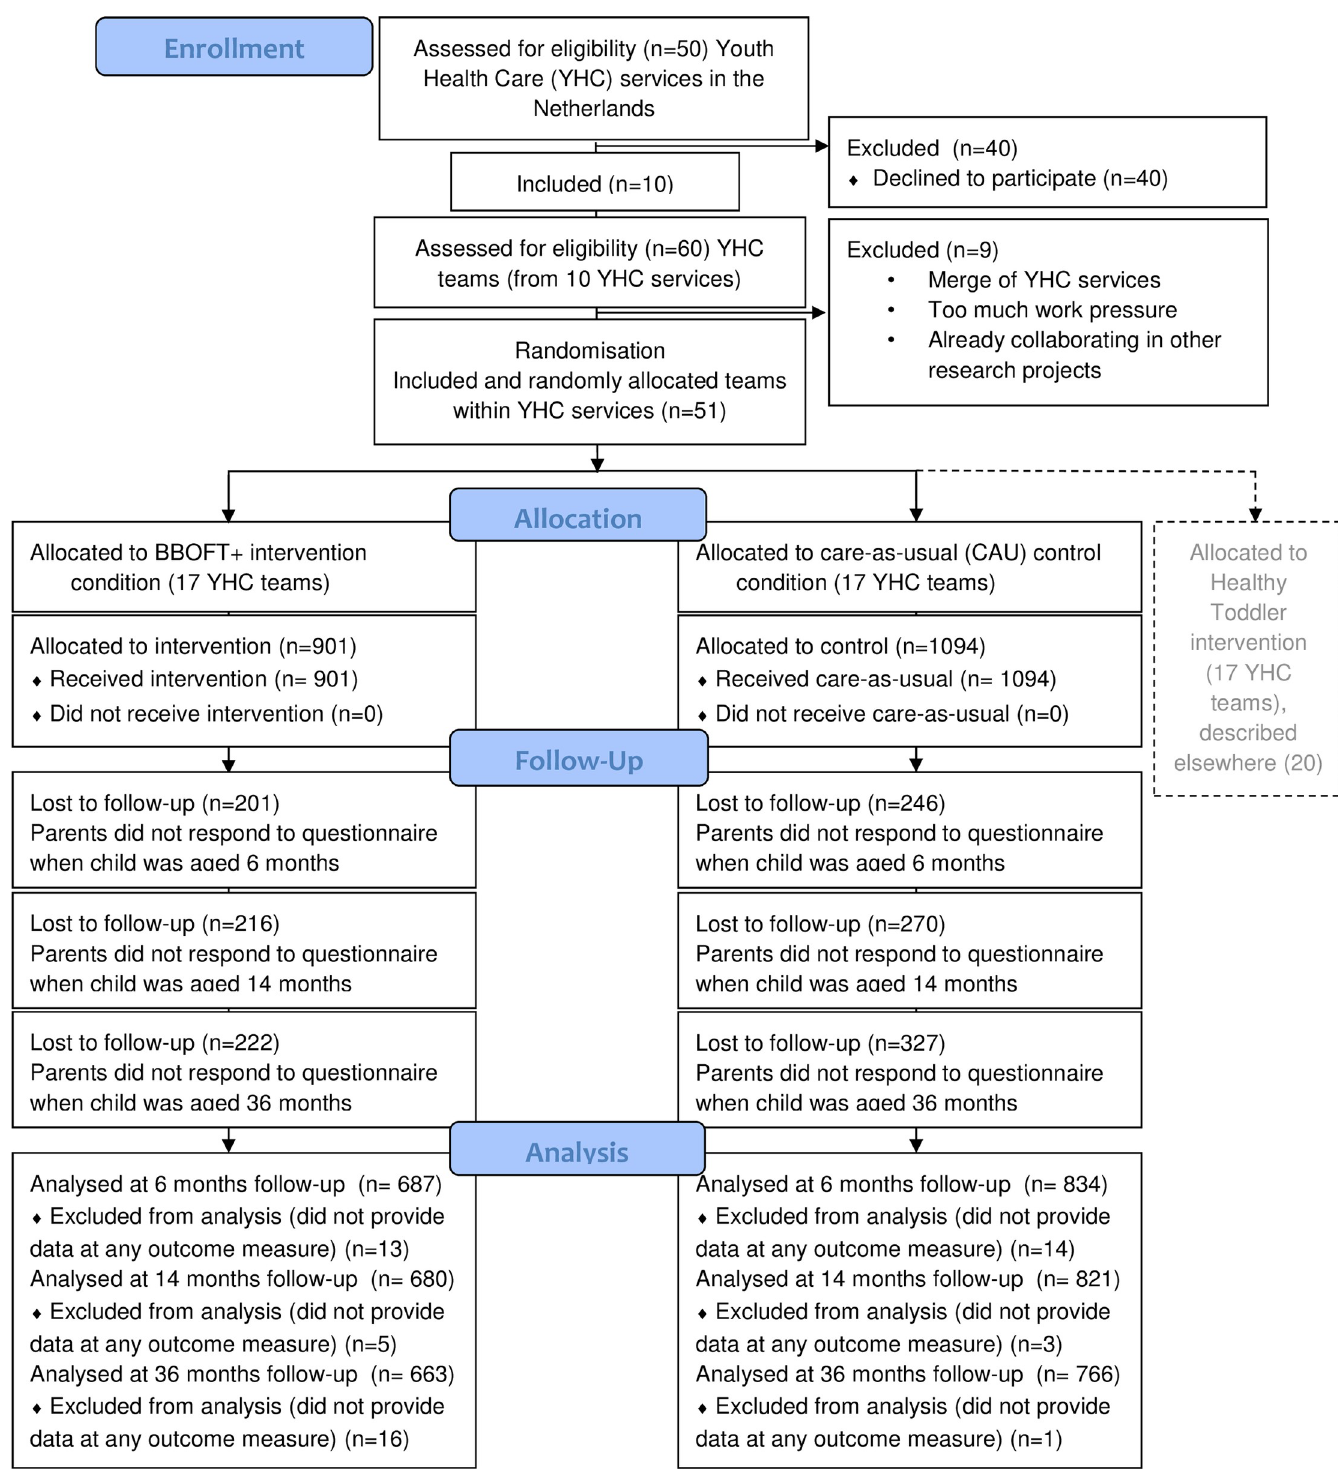
Fig 1. Flow diagram of participants in the study.